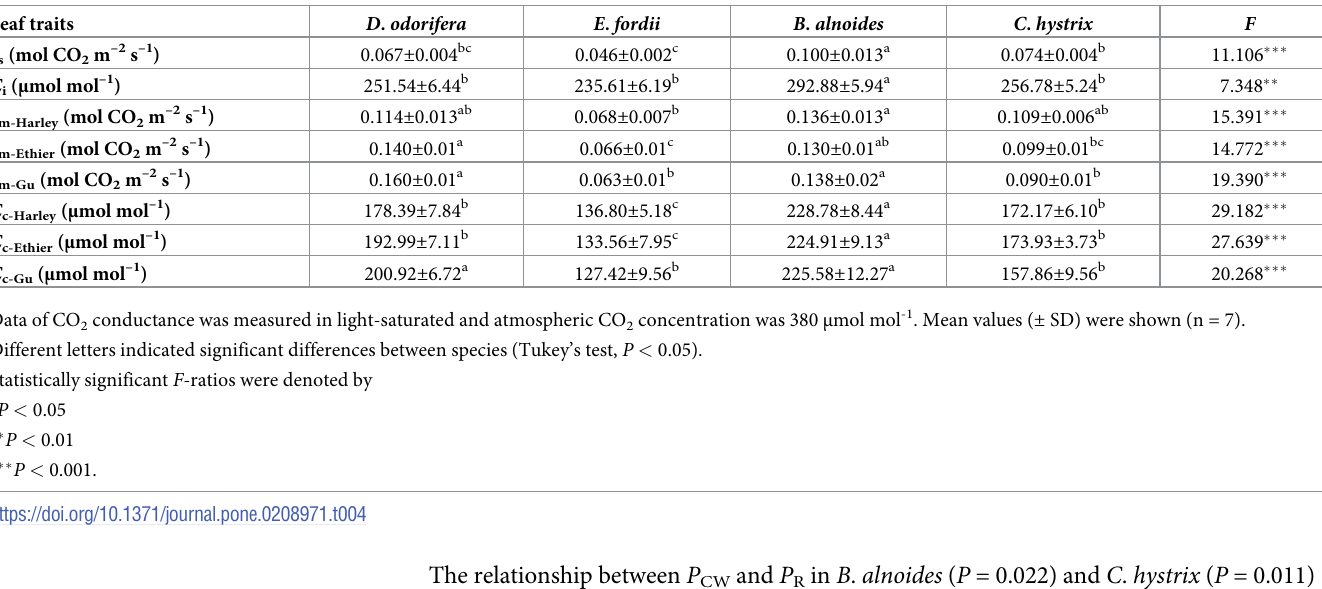
The relationship between P and P in B . alnoides ( P = 0.022) and C . hystrix ( P = 0.011) CW R seedling leaves were more significant than in D . odorifera ( P = 0.409) and E . fordii ( P = 0.637). Regression analysis of P with P in B . alnoides seedling leaves was within the shaded zone; CW R C . hystrix was on the shaded zone; D . odorifera and E . fordii were under the shaded zone (Fig 3).